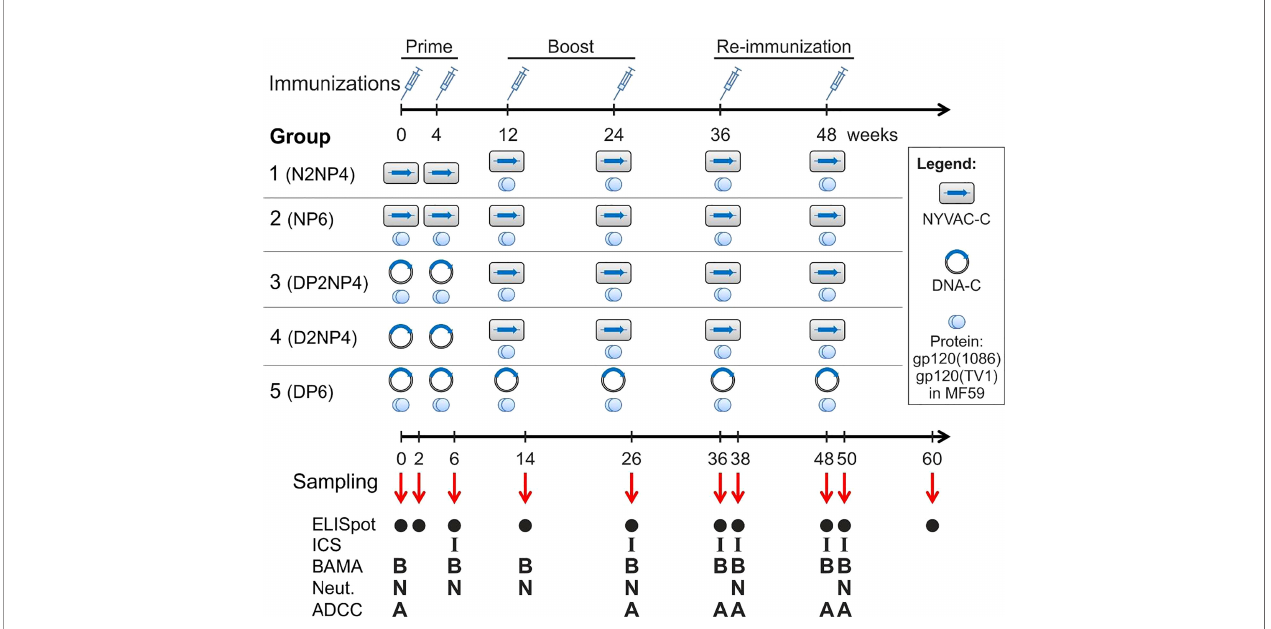
FIGURE 1 | Study design, immunization groups and immunogenicity endpoints of the AUP512 NHP Study. Immunizations with different combinations of candidate HIV-1 vaccines constituting DNA, NYVAC and Env protein were performed by the intramuscular (i.m.) route at weeks 0, 4, 12, 24, 36 and 48. Blood and rectal mucosal secretions were collected for ELISpot, ICS or antibody analyses at the indicated